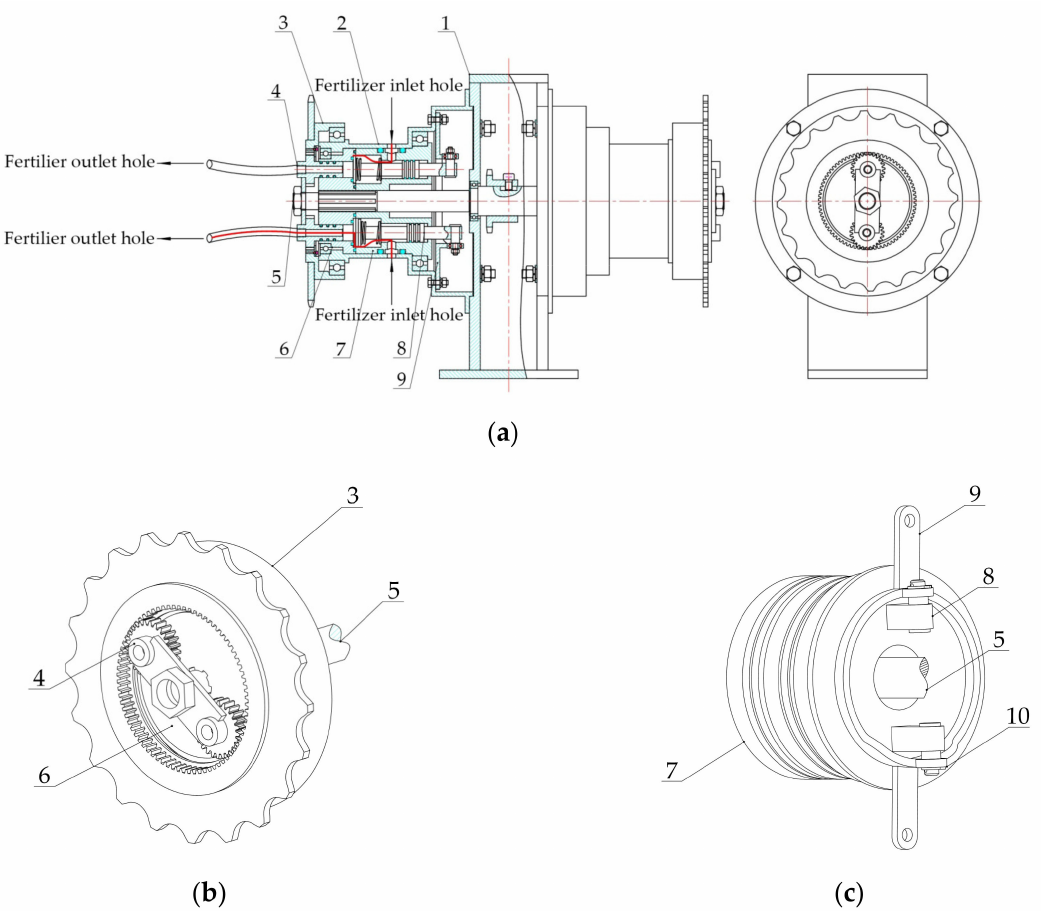
Figure 5. Two-dimensional model of the liquid fertilizer injecting control mechanism. ( a ) Liquid fertilizer injecting control mechanism; ( b ) differential wheel mechanisms; ( c ) cylindrical hollow cam mechanism. 1. sprocket shaft housing; 2. outer housing; 3. inner gear ring; 4. planetary wheel; 5. sprocket shaft; 6. main shaft sleeve; 7. sub shaft sleeve; 8. top bar; 9. cylindrical hollow cams. 10. running